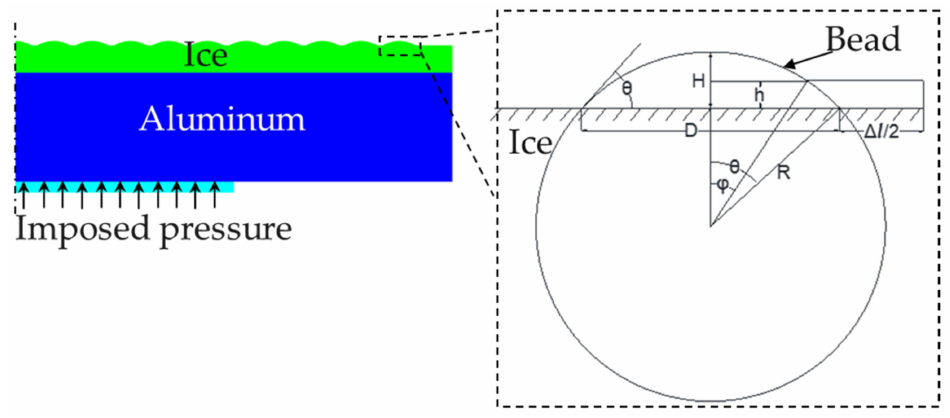
Figure 1. Schematic of a simplified 2-D symmetrical finite element model with bead-like roughness on an ice surface. Table 1. Material